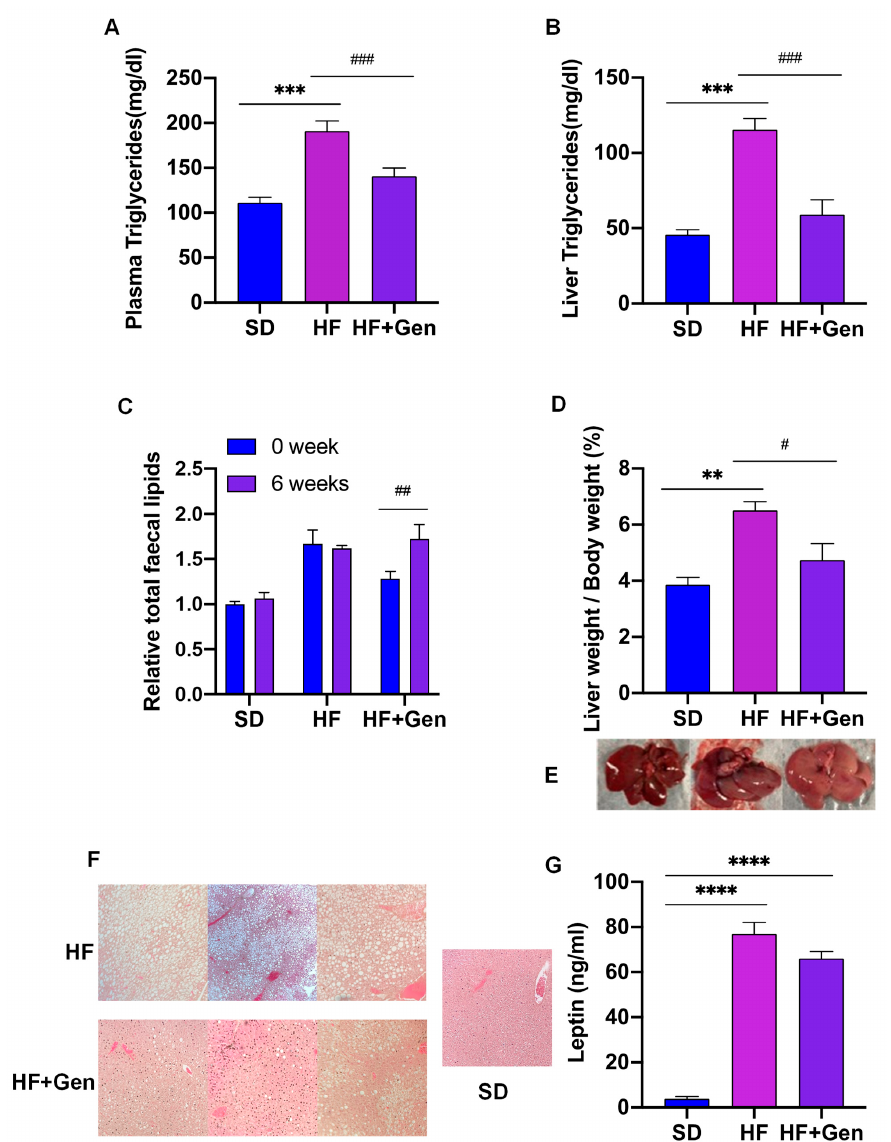
Figure 7. Genipin alleviated HFD-induced lipid accumulation and dysfunction of the livers in obese mice. ( A , B ) At the end of the 6-week treatment, mice were euthanized and blood and liver samples were collected for measuring triglyceride. ( C ) Lipid content in feces collected at 1 week and 6 weeks of treatments were measured. ( D ) Livers were harvested for weight measurement. ( E , F ) A set of representative pictures for liver appearance and H&E-stained images of the liver sections with 200 × magnification are provided. ( G ) ALT levels in plasma were measured using an assay kit. ** p < 0.01, *** p < 0.001, **** p < 0.0001 vs. SD mice; # p < 0.05, ## p < 0.01 and ### p < 0.001 vs. HF